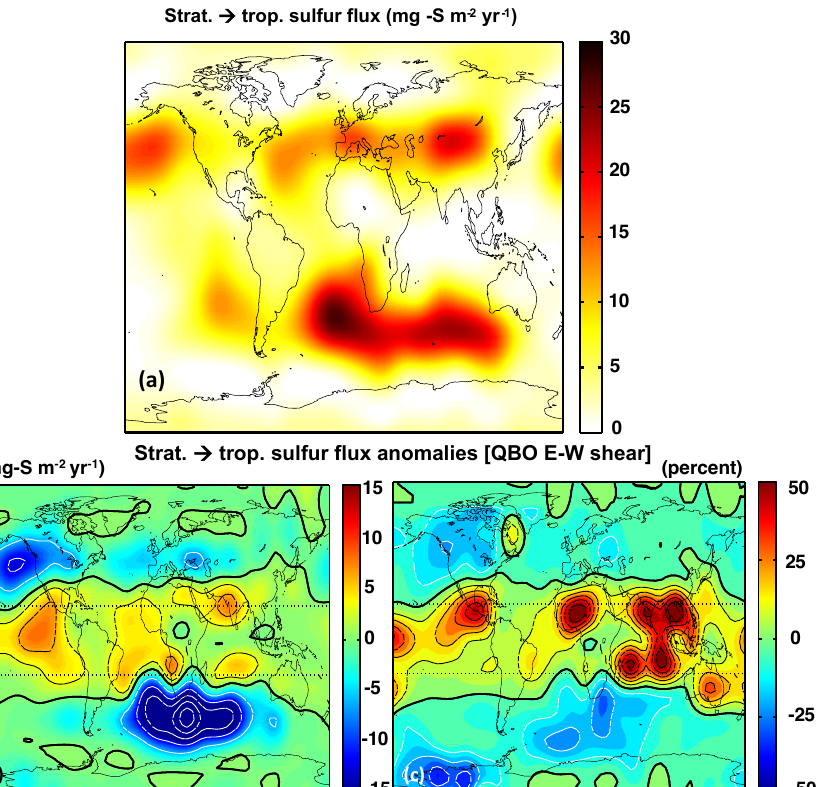
Figure 13. (a) Downward cross-tropopause sulfur flux changes (G4-Base) in ULAQ-CCM, as a function of latitude and longitude and averaged over the years 2030–2039 (mgSm − 2 yr − 1 ). Panels (b, c) as in (a) but showing differences between years with QBO easterly shear and years with QBO westerly shear; (b) shows the difference is in absolute units (mgSm − 2 yr − 1 ), whereas (c) shows the difference in percent of the decadal averaged flux changes presented in (a) . Positive and negative anomalies are separated by the thick black curve (zero contour line); thin black/white curves show positive/negative contours with a step of 5mgSm − 2 yr − 1 in (b) and 10% in (c) ; dotted lines highlight the subtropical barriers at 25 ◦ N and 25 ◦ S. Integrated S-flux anomalies (QBO E–W shear) are as follows: tropics, + 0.61TgSyr − 1 ( + 42%); NH, − 0.51TgSyr − 1 ( − 31%); SH, − 0.35TgSyr − 1 ( − 39%); global, − 0.25TgSyr − 1 ( −